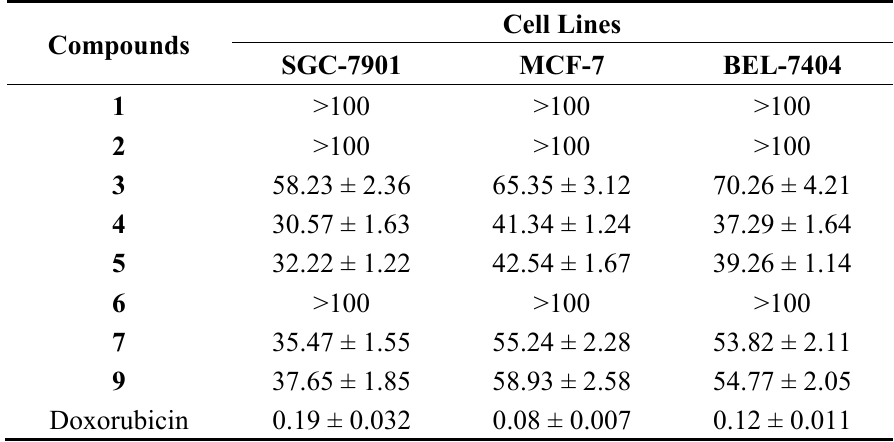
Table 1. Cytotoxicities of compounds 1 – 7 and 9 against three human tumor cell lines (IC 50 , μ